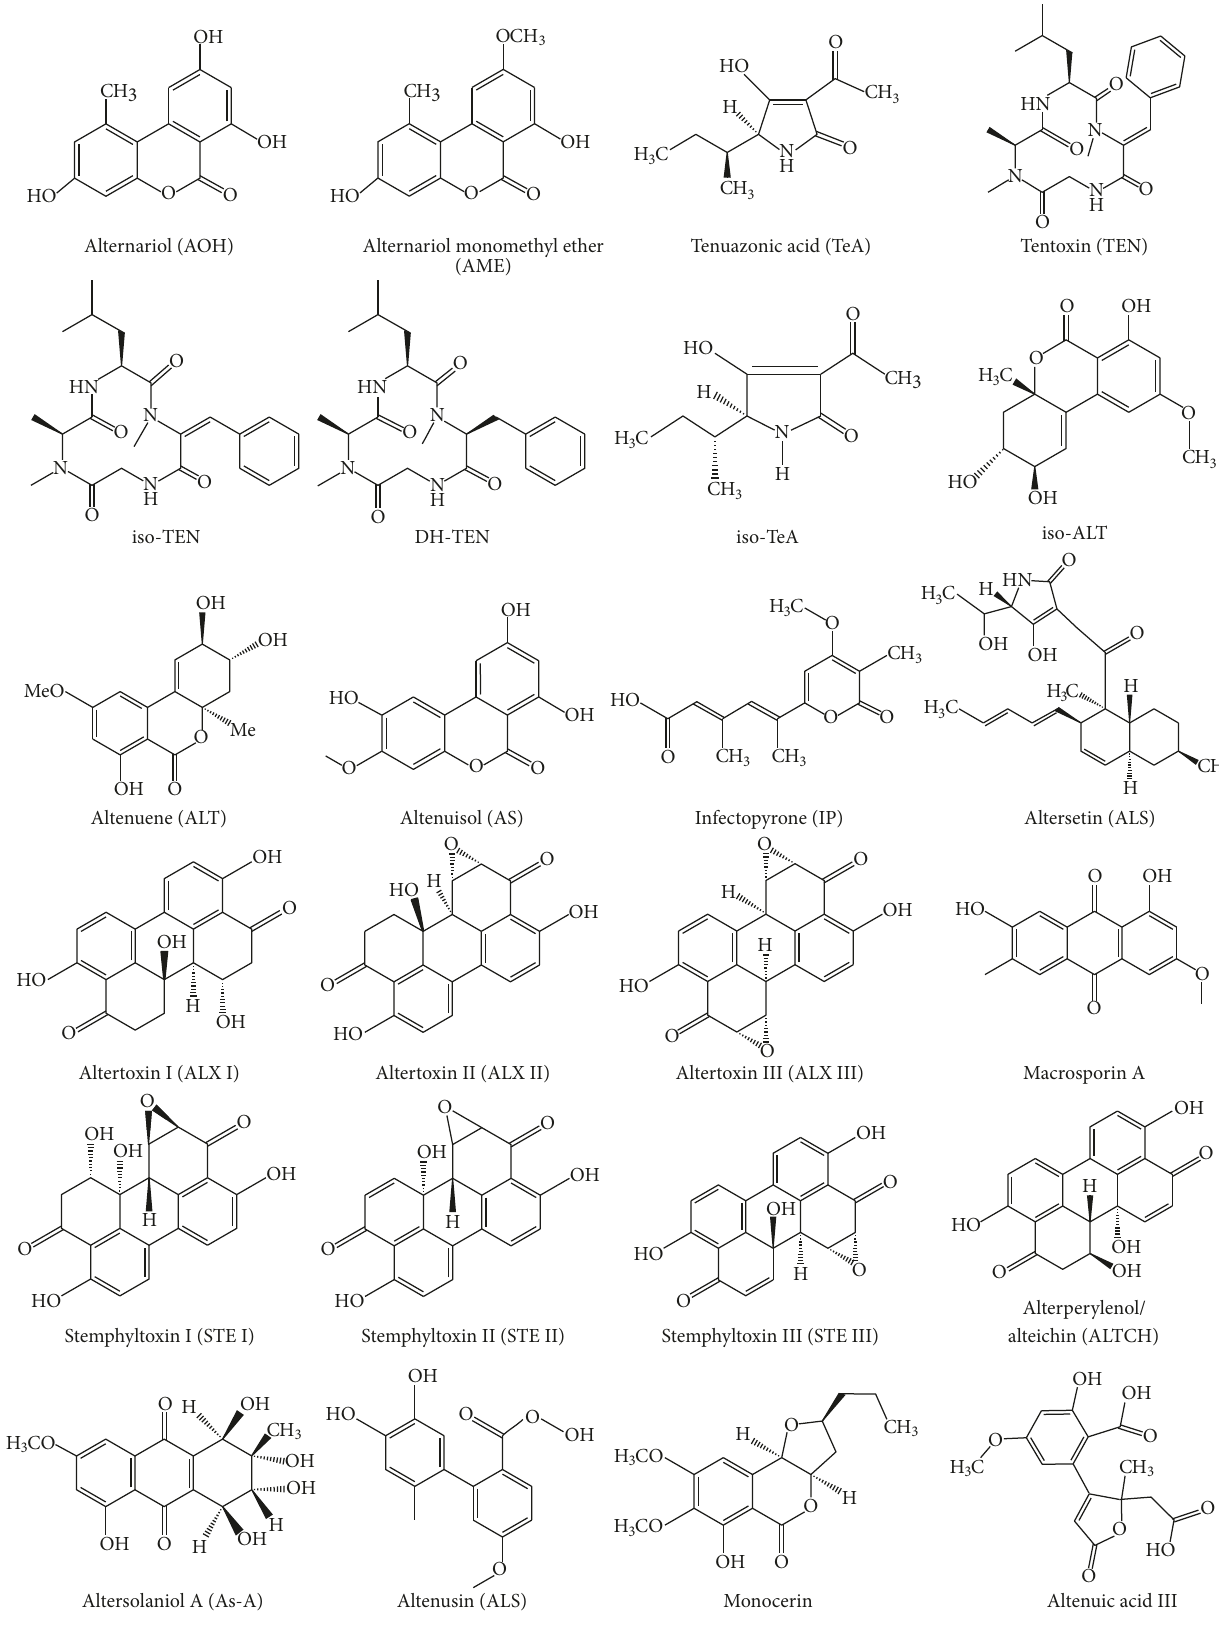
Figure 1: Chemical structure of the main Alternaria